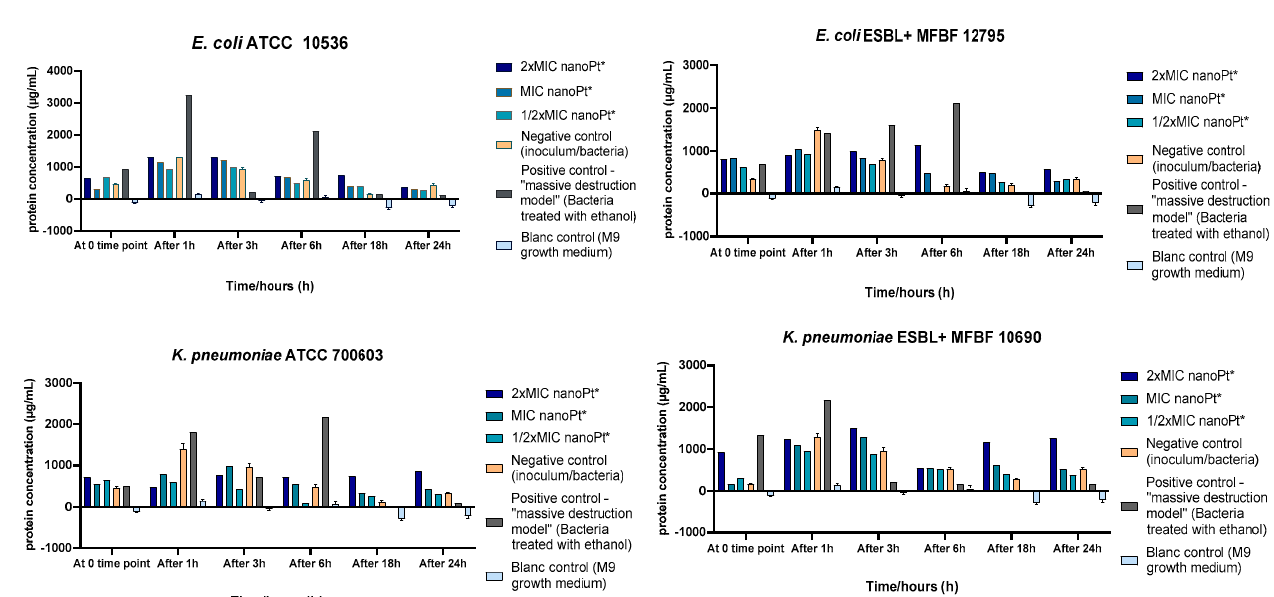
Figure 8. Interrelation of extracellular protein concentrations over time for all tested bacterial strains. nanoPt*—platinum nanoparticles.